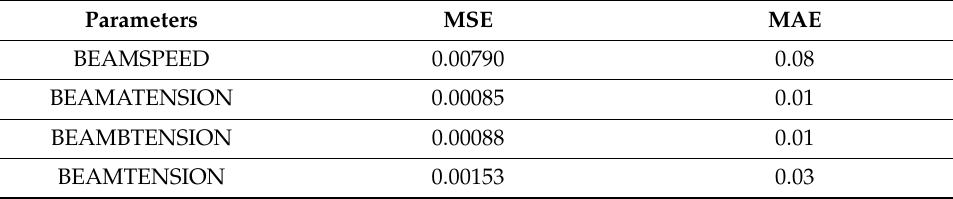
Table 16. Lasso regression results for the beaming